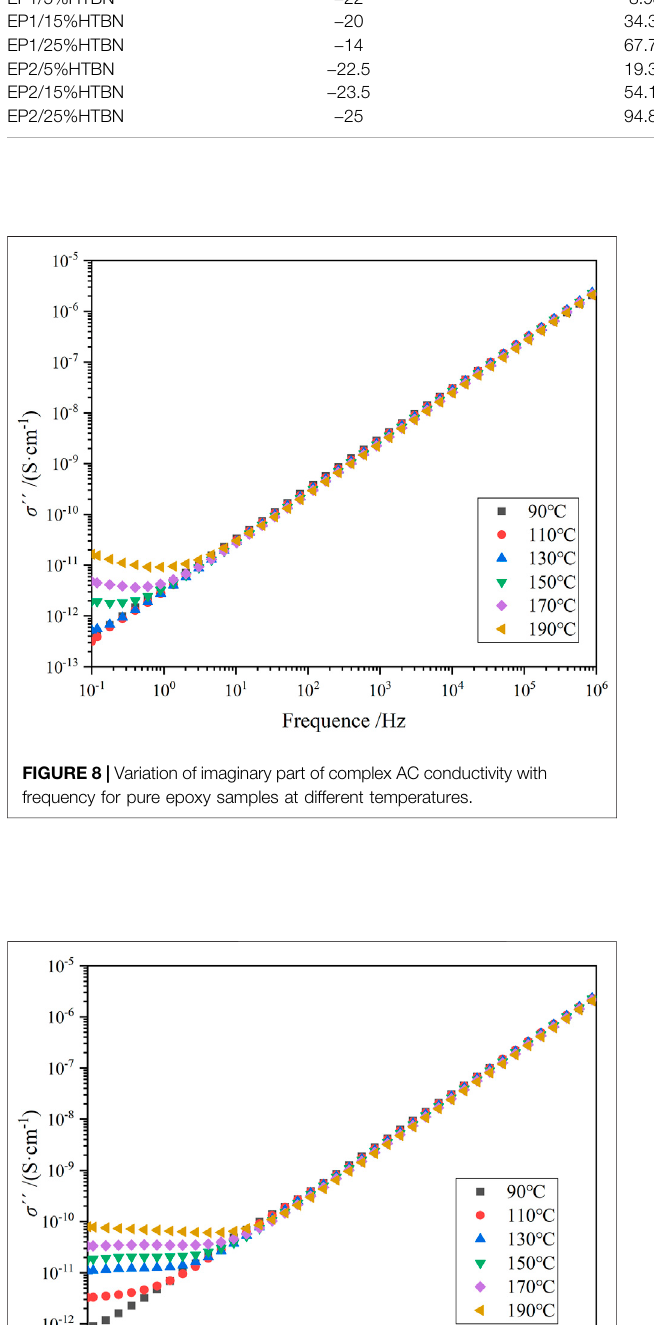
Frontiers in Chemistry |